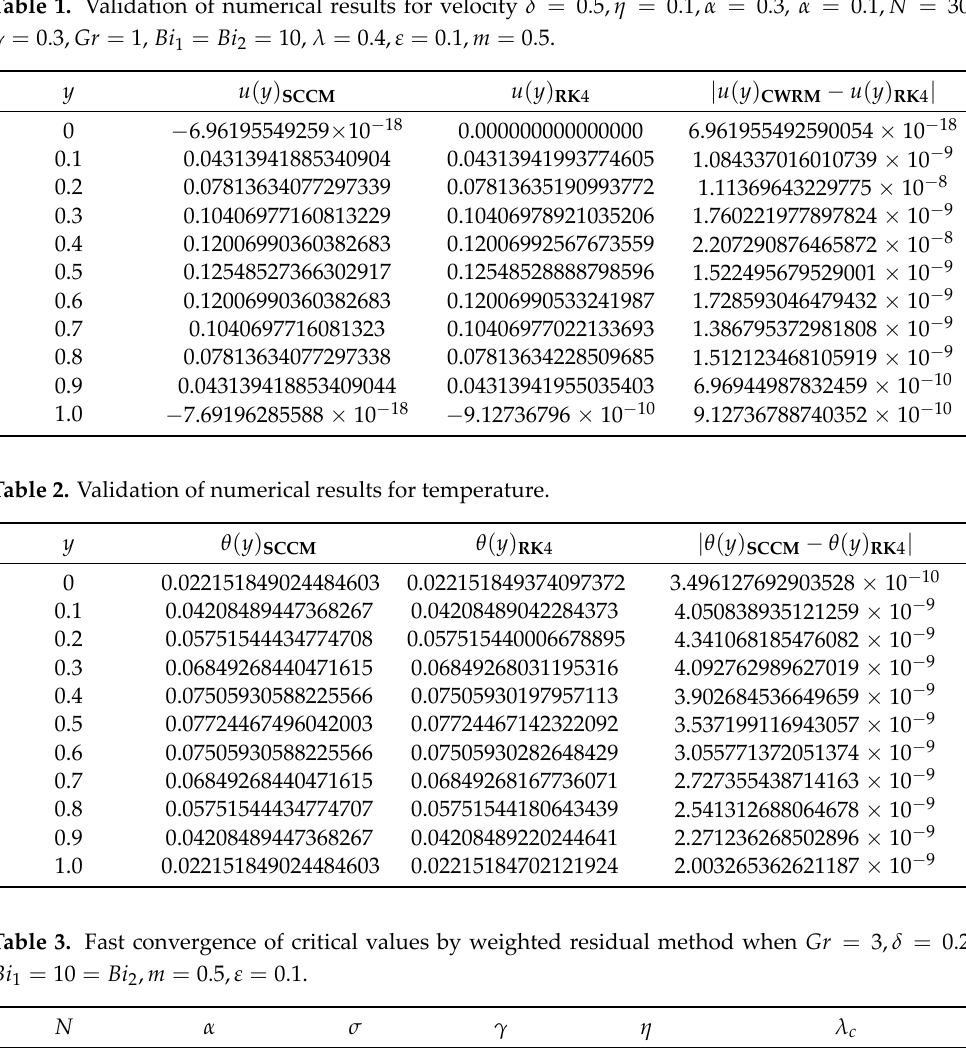
Table 1. Validation of numerical results for velocity δ = 0.5, η = 0.1, α = 0.3 , α = 0.1, N = 30,